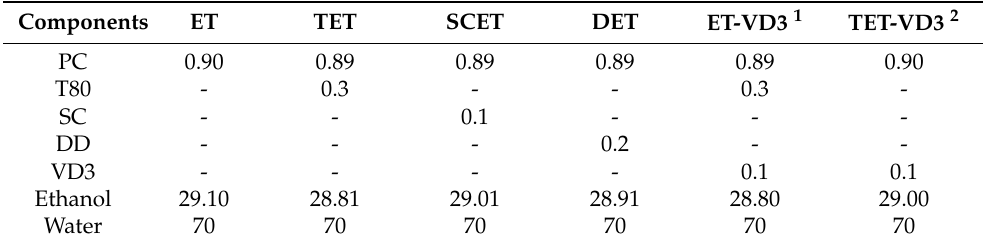
Table 1. Composition of nanocarriers ( w / w %).